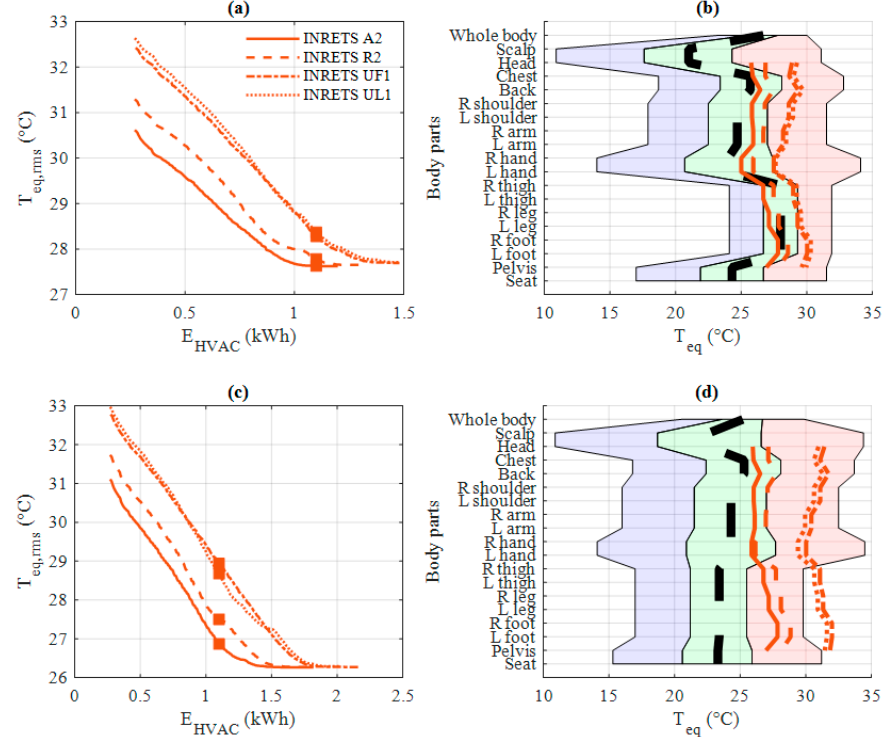
Figure 13. Pareto frontiers and the mean local equivalent temperatures for four INRETS cycle, in which (cid:1846) (cid:3032)(cid:3051)(cid:3047),(cid:2868) = 32 °C , (cid:1844)(cid:1834) (cid:3032)(cid:3051)(cid:3047),(cid:2868) = 55% , (cid:1869)(cid:4662) (cid:3046)(cid:3048)(cid:3041) = 1000 (cid:1849)/(cid:1865) (cid:2870) , and where the driver is dressed in: ( a , b ) informal way, ( c , d ) formal way.